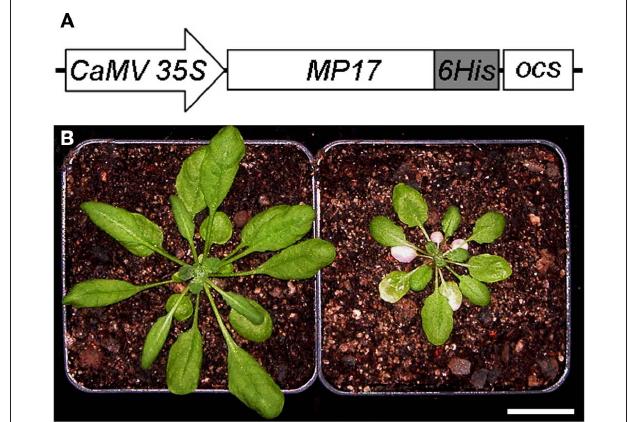
FiguRe 3 | Stable expression of MP17:HiS in Arabidopsis. (A) Schematic drawing of the MP17:His fusion construct containing C-terminal six histidine residues; (B) ATPMH2 plants (right) showing chlorotic source leaves and stunted growth as compared to wild type (left); bar shows 2